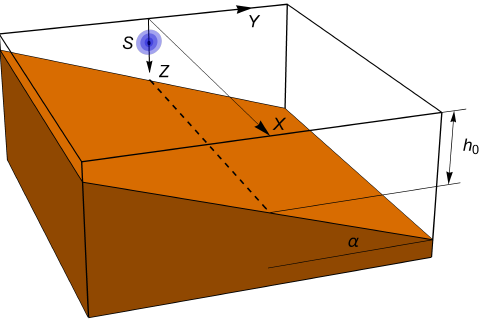
Figure 2. Coastal wedge with penetrable